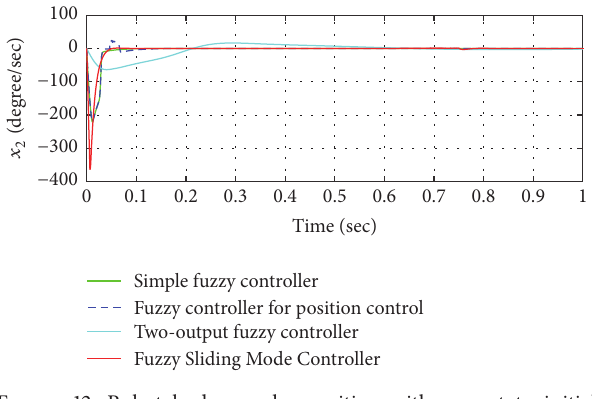
Figure 12: Robot body angular position with respect to initial ́𝜃 = 0 . condition, 𝜃 = 5 ∘ and